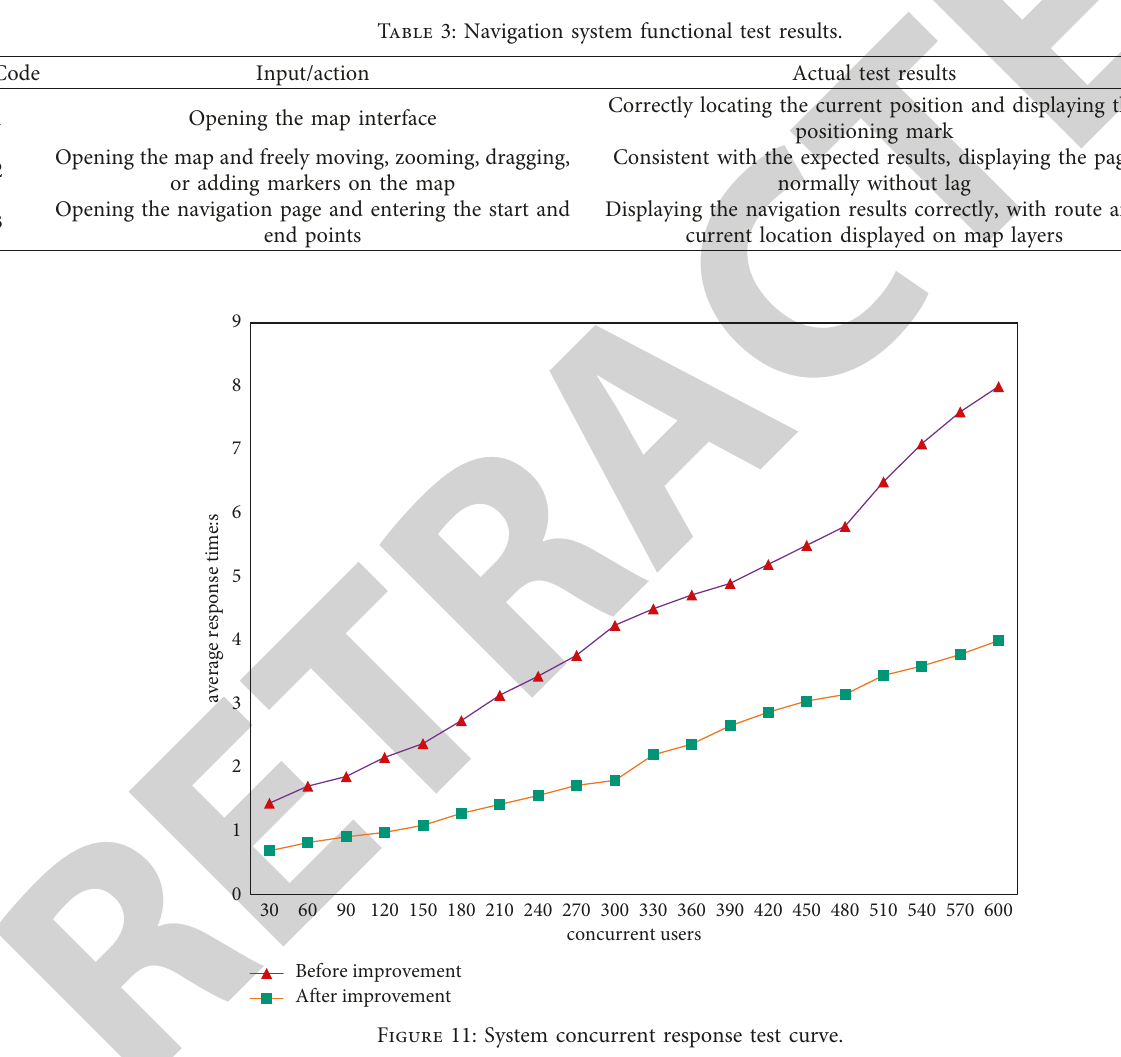
Figure 11: System concurrent response test